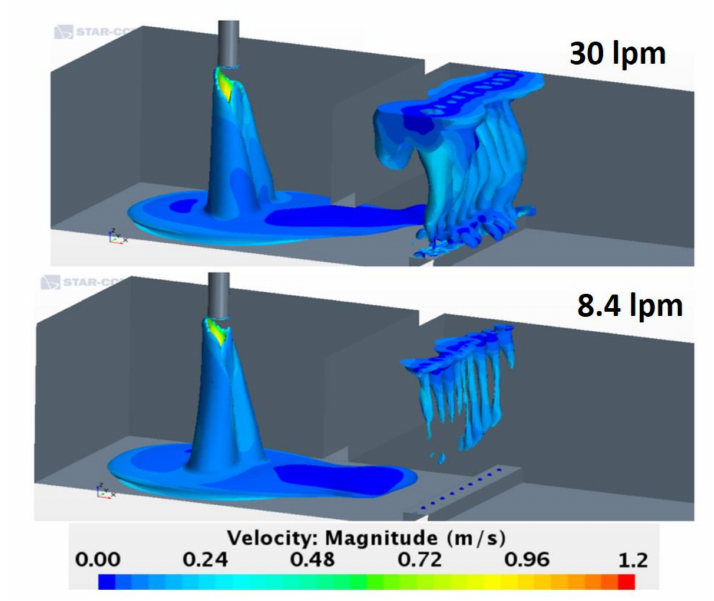
Figure 12. Isosurfaceofturbulencekineticatdifferentgasflowrates. (Case3-W + LD + G, k = 0.0035 J kg − 1 , Q = 8.4, 30